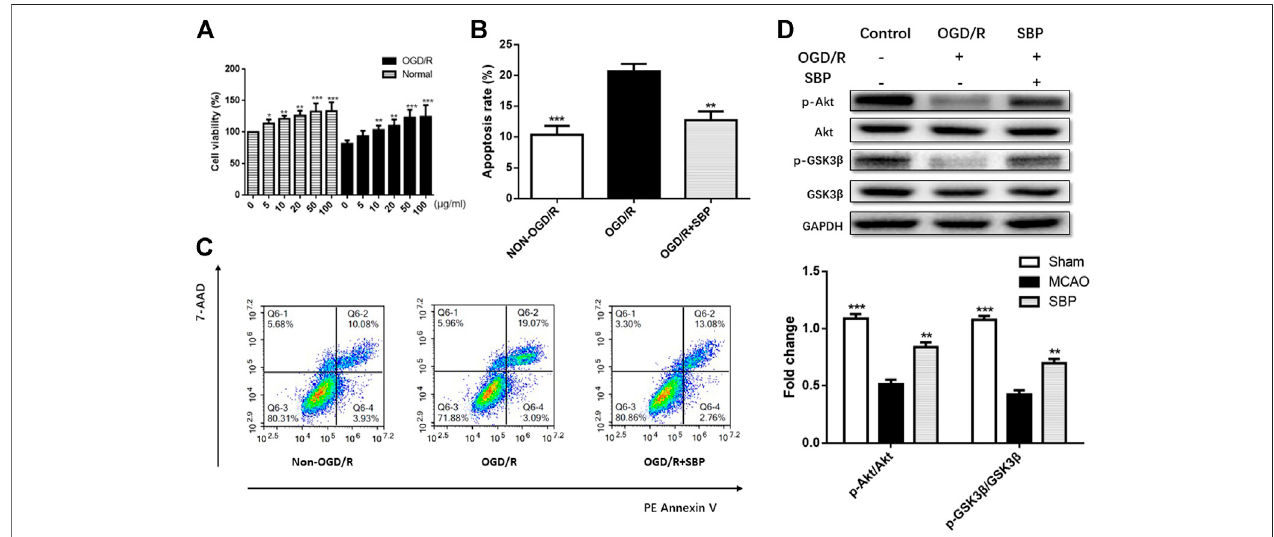
FIGURE1| SBPenhancedcellviabilityanddownregulatedapoptosis,andupregulatedtheexpressionofp-Akt/Aktandp-GSK3 β /GSK3 β invitro . (A) CCK8assay forcell viabilityinCATH. acells underOGD/RconditionswithorwithoutSBP. (B,C) TheapoptosisofCATH. awasassessed by fl owcytometry, and theresultsshowed that OGD/R can enhance apoptosis, while the apoptosis was downregulated upon SBP treatment. (D) The protein levels of p-Akt/Akt and p-GSK3 β /GSK3 were upregulated and activated by SBP. All data are means ± SEM, n (cid:2) 3; * p < 0.05, ** p < 0.01, and *** p < .001 compared to OGD/R group.